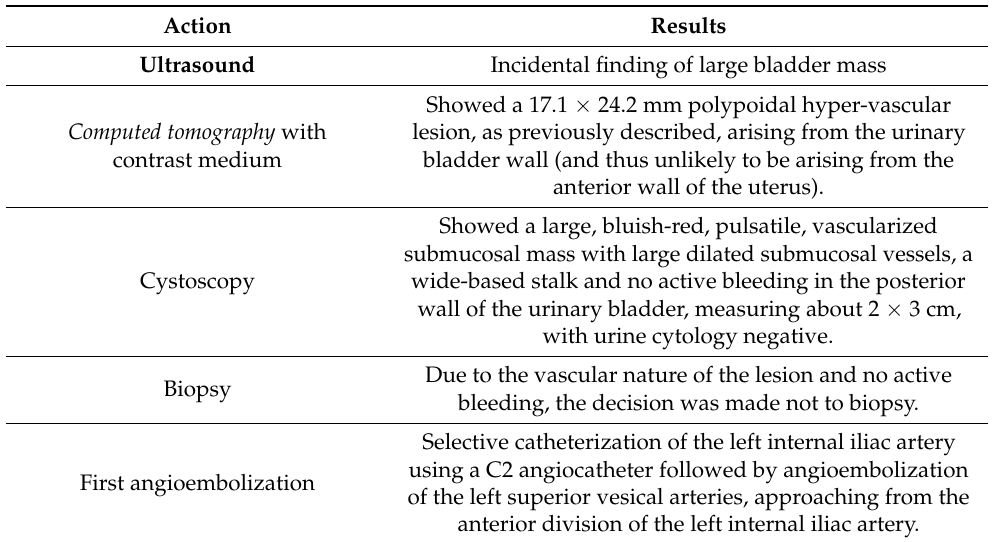
Table 1. Summary of case management at the time of presentation in